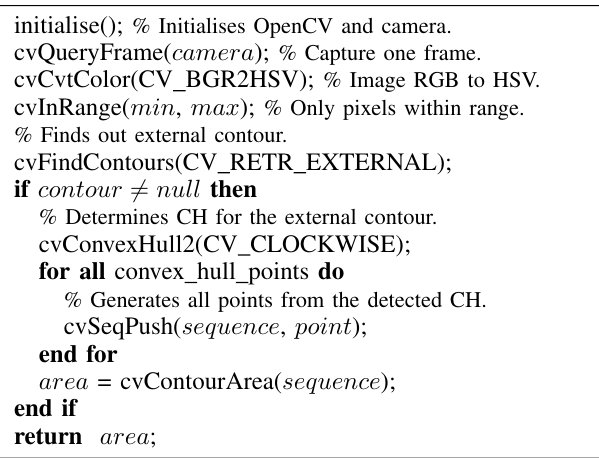
Algorithm 2 The Controller Algorithm